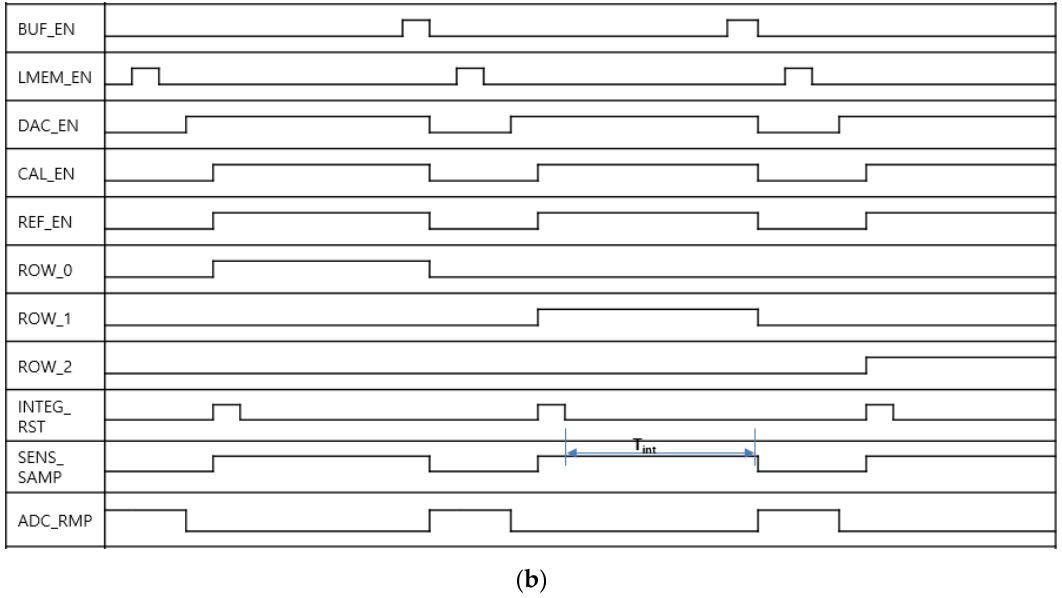
Figure 5. ( a ) Schematic of column readout circuit with integrator for current to voltage conversion, ( b ) timing diagram of entire chip.